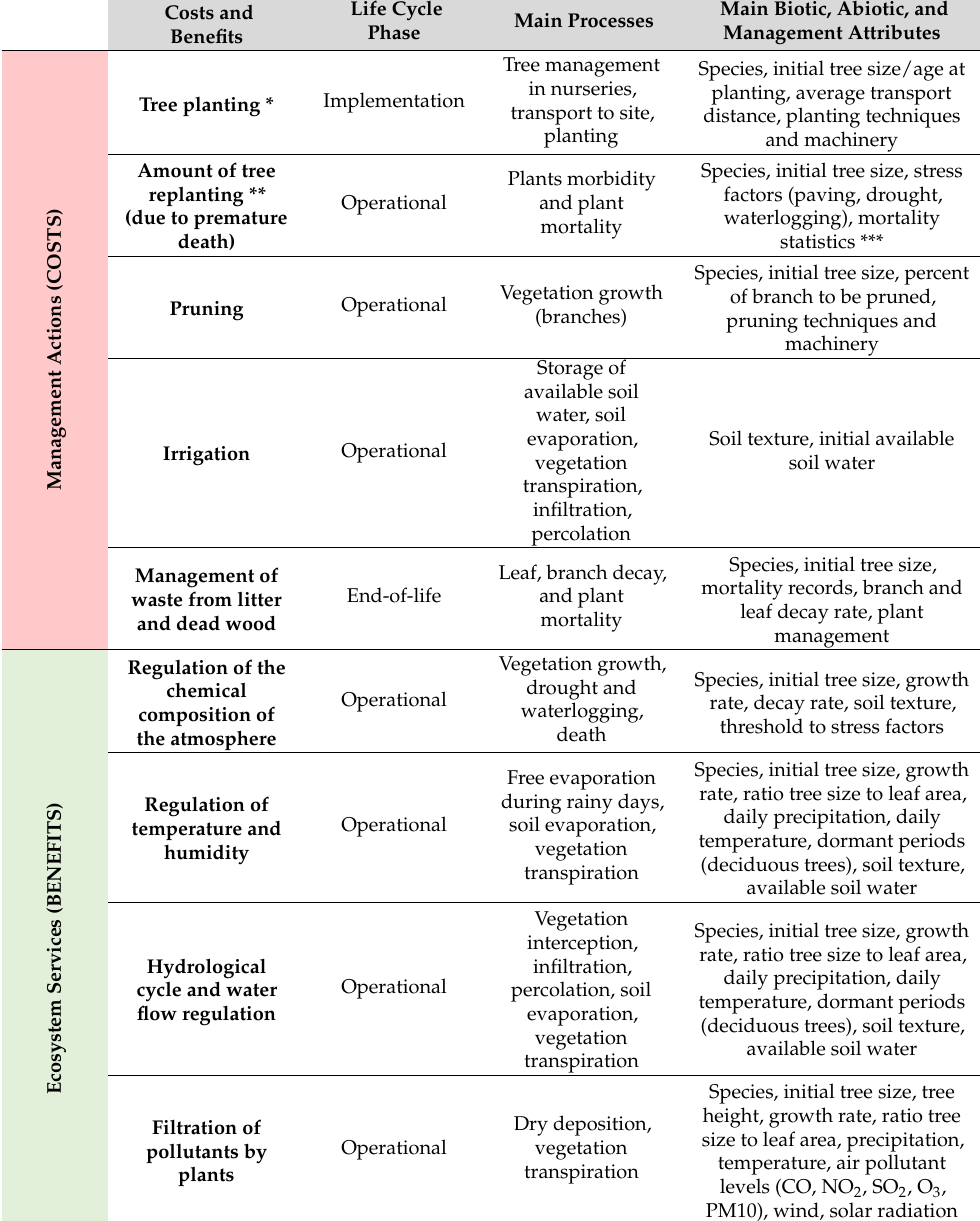
Table 1. Costs and benefits of urban forests, the main processes influencing outputs, and the main attributes influencing